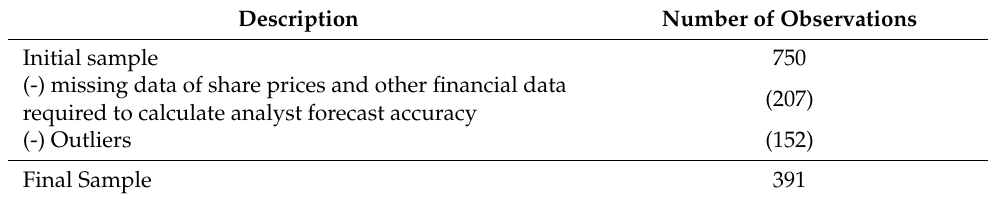
Table 1. Sample selection: the distribution of observations based on initial sample selected among listed companies in Malaysia that are followed by